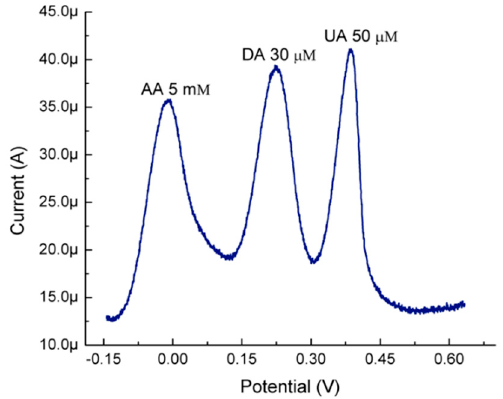
Figure A1. A DPV curve for a simultaneous determination of 5 mM AA, 30 µ M DA, and 30 µ M DA under a scanning potential from − 0.15 V to 0.7 V. The working electrode consisted of graphene oxide (GO) prepared by the Hummer method grafted by electropolymerized serine. This separation of the oxidation peaks was observed only when poly-serine was applied on the prepared GO surface.